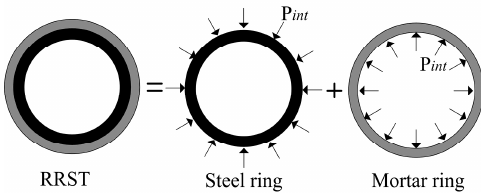
Figure 6. Illustration for computing stress.